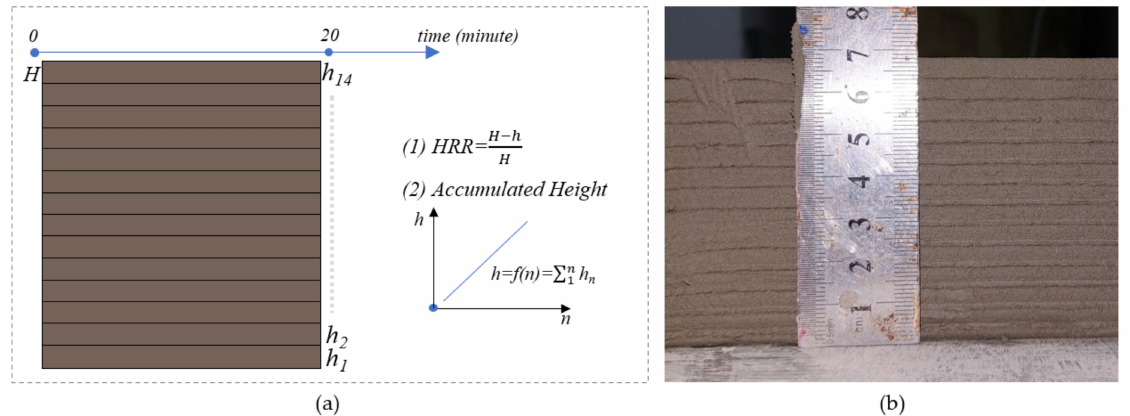
Figure 4. Buildability tests: ( a ) illustrations of HRR and height accumulation and ( b ) actual buildabil- ity